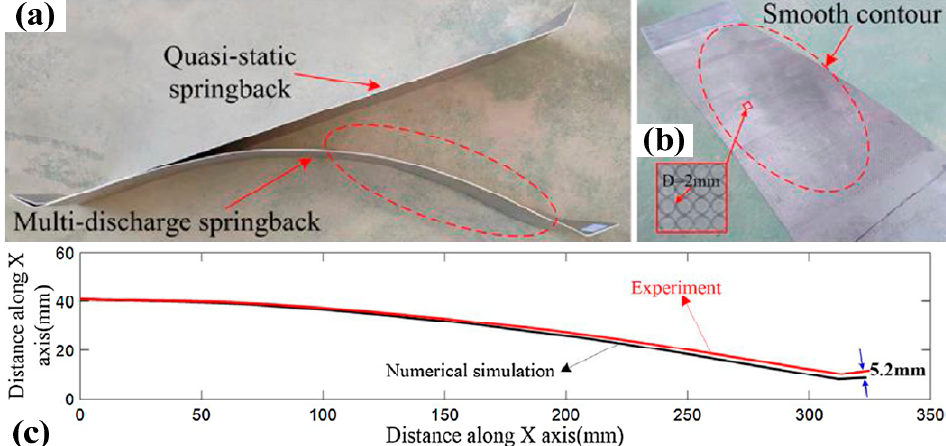
Figure 16. Springback results of 3033 aluminum alloy sheets obtained by conventional stretching and electromagnetic partitioning forming [12]. Reprinted with permission from Ref. [12]. Copyright 2022, J. Mater. Process. Tech. ( a ) Quasi-static and multi-discharge springback, ( b ) surface contour of obtained arc part and ( c ) comparison of the cross-section profiles of experiment and numerical simulation.